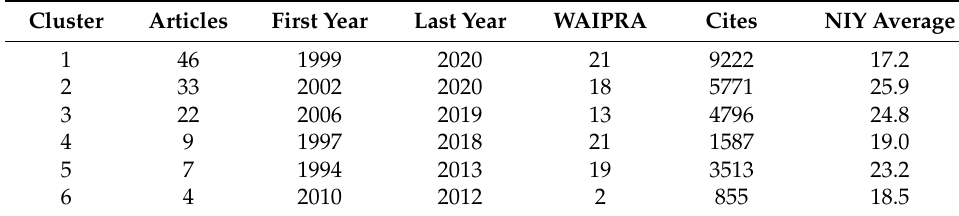
Figure 5. Bibliographic coupling of articles. Table 7. Bibliographic coupling of articles . Table 7. Bibliographic coupling of